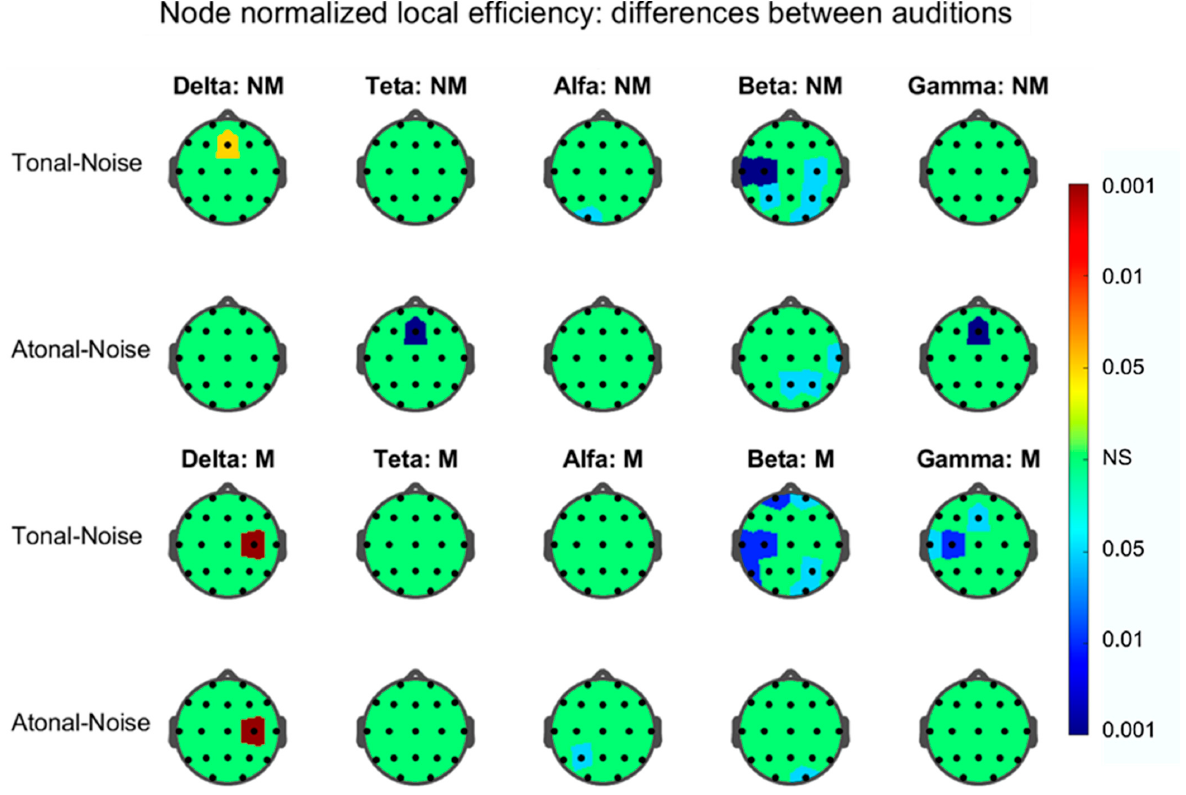
Figure 10. As in Figure 9 but for the normalized local efficiency.